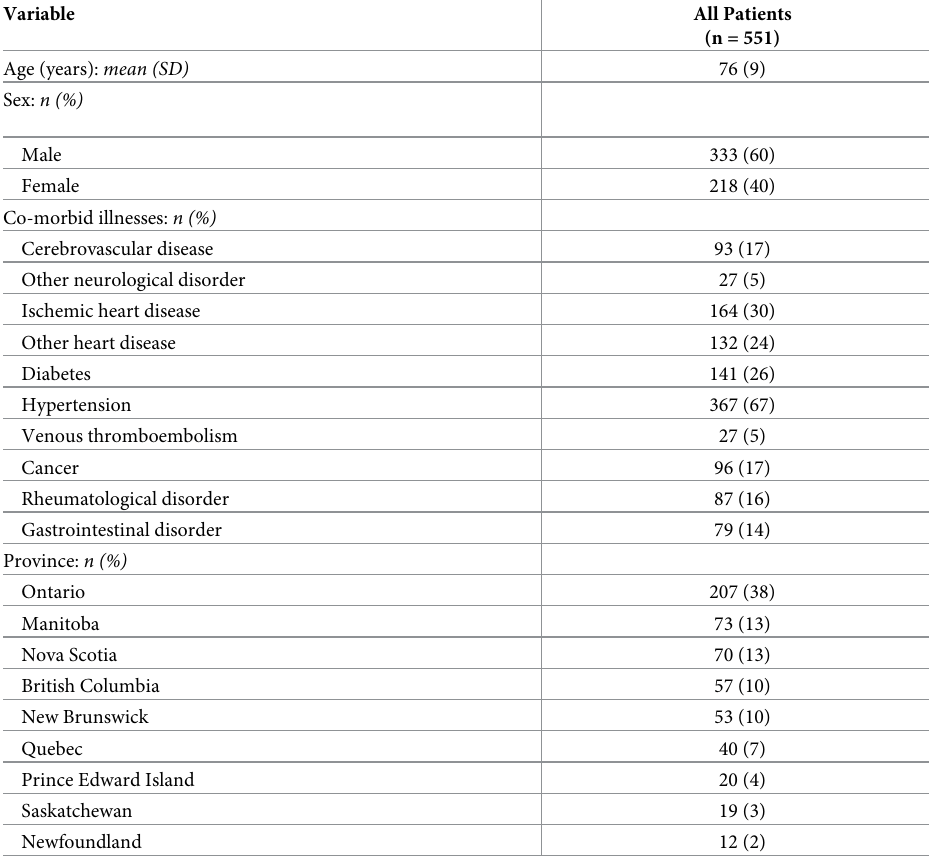
Table 1. Baseline